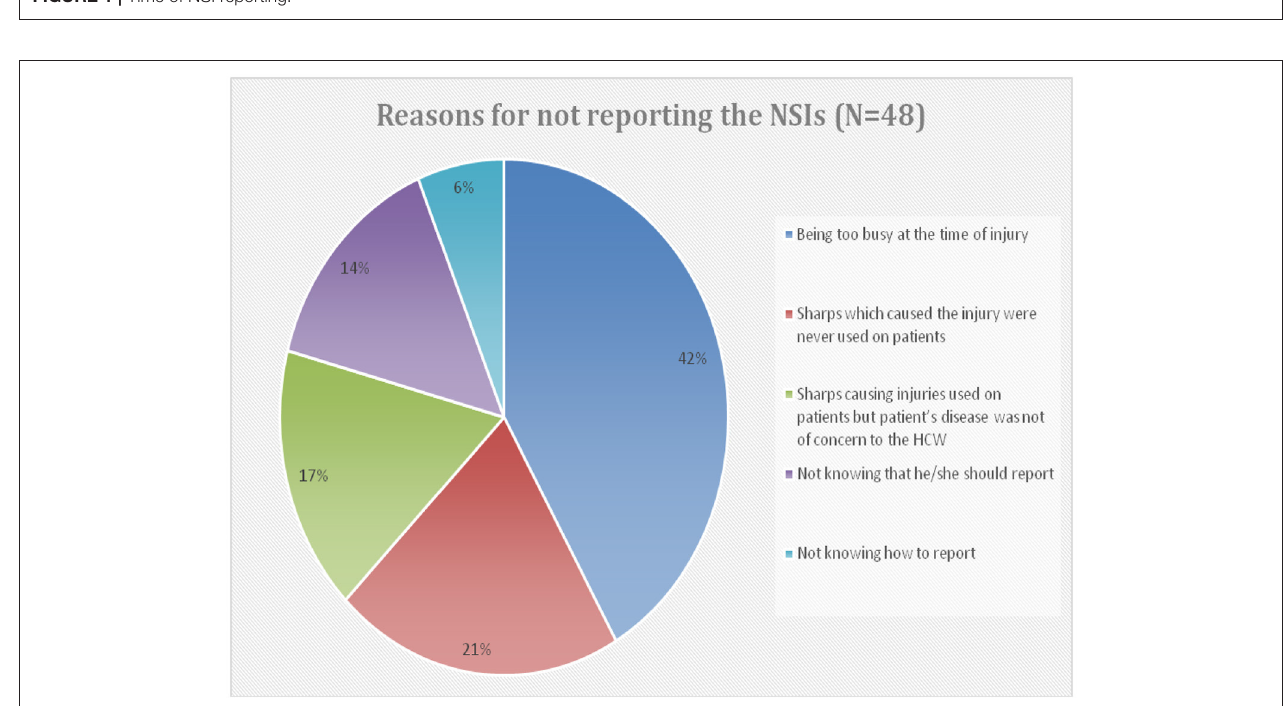
FIGURE 2 | Reasons for not reporting the NSIs among those HCWs who did not report their NSIs (48/91).